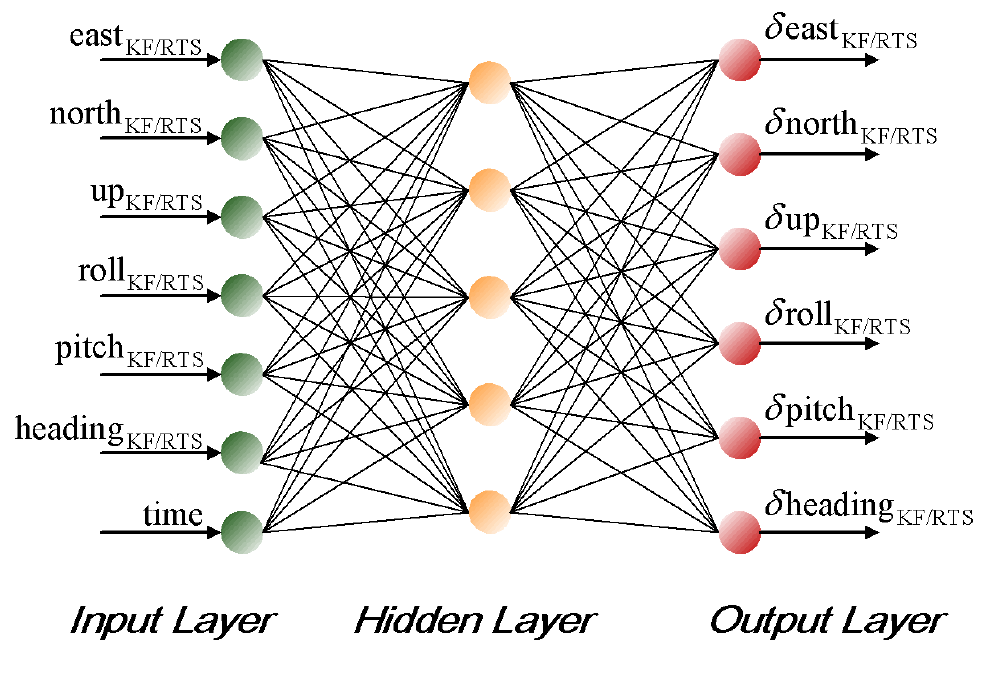
Figure 9. The topology of proposed ANN